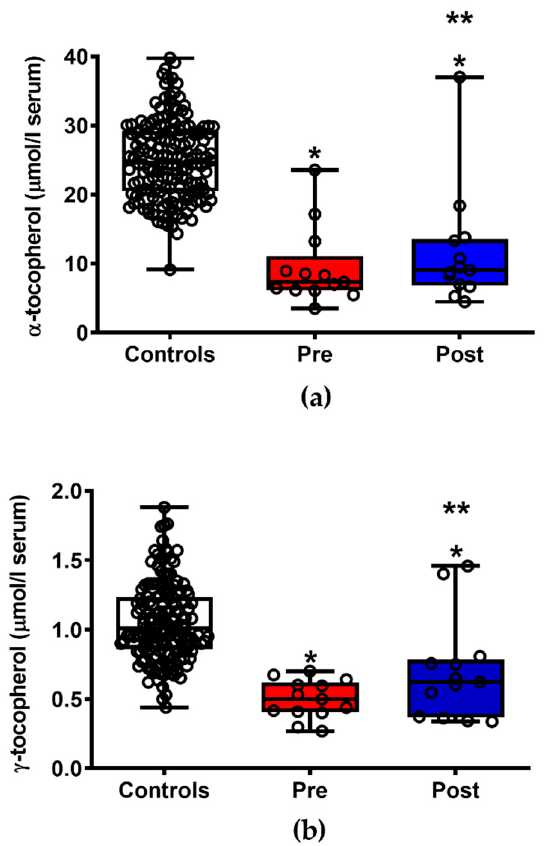
Figure 4. Box plots reporting minimum, maximum, median, 25% and 75% percentiles of the serum concentrations of the main vitamin E congeners ( α -tocopherol, ( a ) and γ -tocopherol, ( b )) in patients with ALS before (Pre) and after (Post) ILB ® treatment. The values measured in a group of 163 healthy controls are also reported. ( ○ ) Open circles are the values of metabolites in each subject enrolled in the study. Means ± S.D. of α -tocopherol in controls, patients with ALS before (Pre) and after (Post) ILB ® treatment were, respectively, 25.03 ± 5.78, 9.35 ± 5.54 and 11.70 ± 8.50 µmol/L serum. Means ± S.D. of γ -tocopherol in controls, patients with ALS before (Pre) and after (Post) ILB ® treatment were, respectively, 1.05 ± 0.28, 0.497 ± 0.139 and 0.692 ± 0.367 µmol/L serum. * Significantly different from Controls, p < 0.001. ** Significantly different from Pre, p < 0.05.